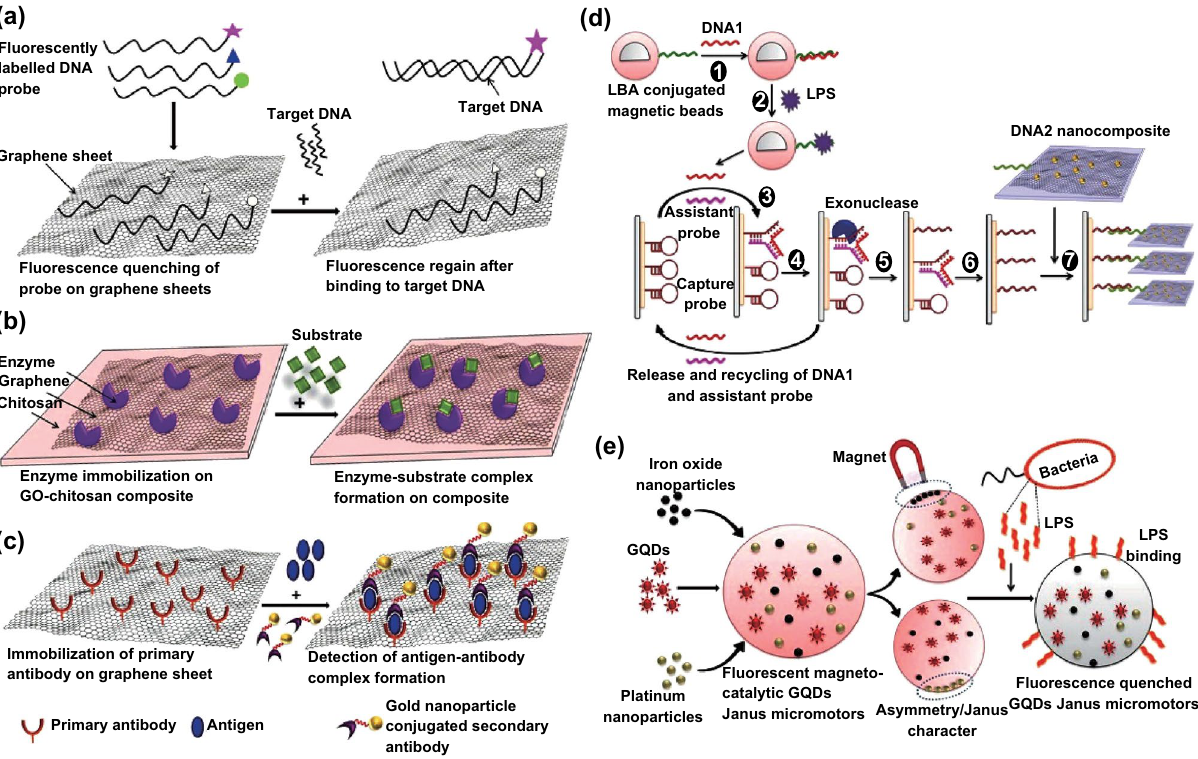
Fig. 4 Graphene-based biosensors. a FRET-based graphene sensors for the detection of target DNA using fluorescent-labeled ssDNA. b Gra- phene biosensors for the immobilization of enzymes to monitor enzyme activity. c Graphene immunosensor for the detection of an antigen–anti- body complex for early disease diagnosis. d Graphene nanohybrid electrochemical aptasensor for endotoxin detection. Step 1: Complementary DNA 1 is hybridized to LBA. Step 2: LPS binds to LBA, promoting the release of DNA 1. Step 3: Together with the help of an associated probe, DNA 1 binds to a capture probe and forms a Y-shaped structure. Step 4: Exonuclease nicking cleaves the capture probe and releases both DNA 1 and the assistant probe. Step 5: DNA 1 and the assistant probe are rehybridized to the new capture probe, and the cycle continues. Step 6: More numbers of cleaved capture probes are formed. Step 7: Capture probes are hybridized to DNA 2 nanocomposites, resulting in the production of electrochemical signals. e Structure of the magnetocatalytic GQD-based Janus micromotors and fluorescence quenching upon binding of